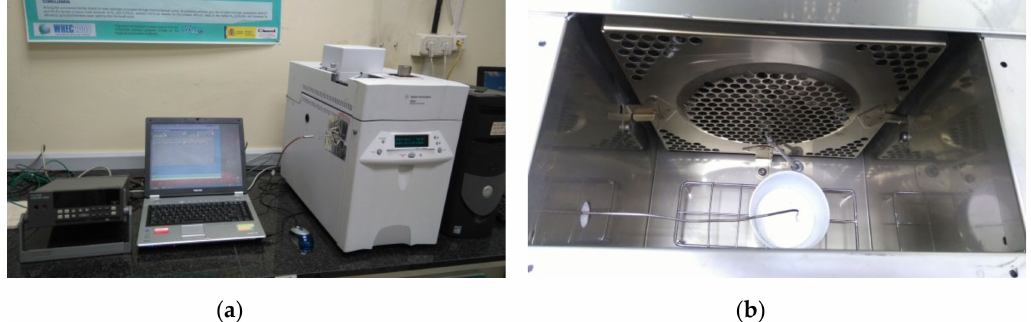
Figure 2. Setup outside ( a ) and oven inside ( b ) of the device “CIEMAT